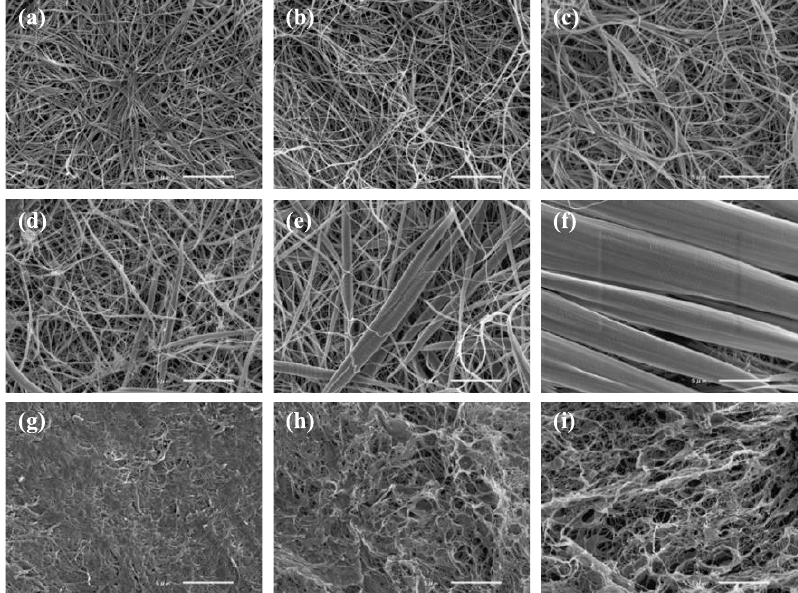
Figure 8. Scanning electron micrographs of skin collagen, swim bladder collagen, and porcine tendon collagen fibrils formed at 21 ± 1 °C for 24 h. ( a – c ) bester skin with NaCl concentrations of 0, 70, and 140 mM; ( d – f ) bester swim bladder with NaCl concentrations of 0, 70, and 140 mM; ( g – i ) porcine collagen with NaCl concentrations of 0, 70, and 140 mM. Scale bars, 5 μm [227].